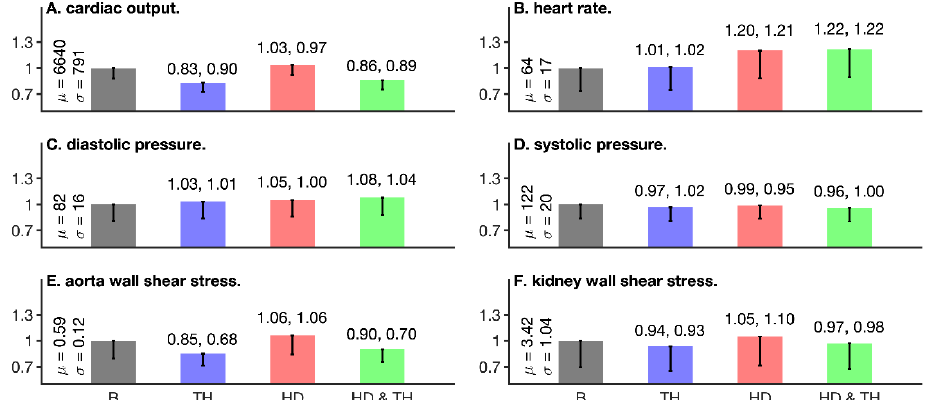
Figure 4. Model generated clinical measurables (model outputs) in the four populations (B, TH, HD, HD&TH). In all panels, B (gray bars) represents baseline model outputs, TH (blue bars) represents model outputs under therapeutic hypothermia, HD (red bars) represents hemodialysis, and HD&TH (green bars) represents simulation application of hemodialysis and therapeutic hypothermia. Panel ( A ) shows cardiac output, ( B ) shows heart rate, ( C ) shows diastolic cardiac pressure, ( D ) shows systolic cardiac pressure, ( E ) shows WSS in the aorta, and ( F ) shows wall shear stress in the right kidney. The black line in each bar represents the standard deviation. The mean values and standard deviations for baseline are provided in all panels. The mean values ( μ ) and standard deviations ( σ ) relative to the respective baseline values are provided for TH, HD, and TH&HD cases in all panels.